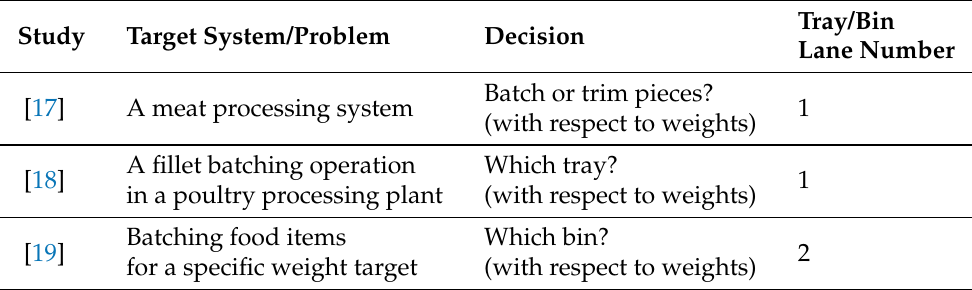
Table 1. Related work for a robotic arm-based batching